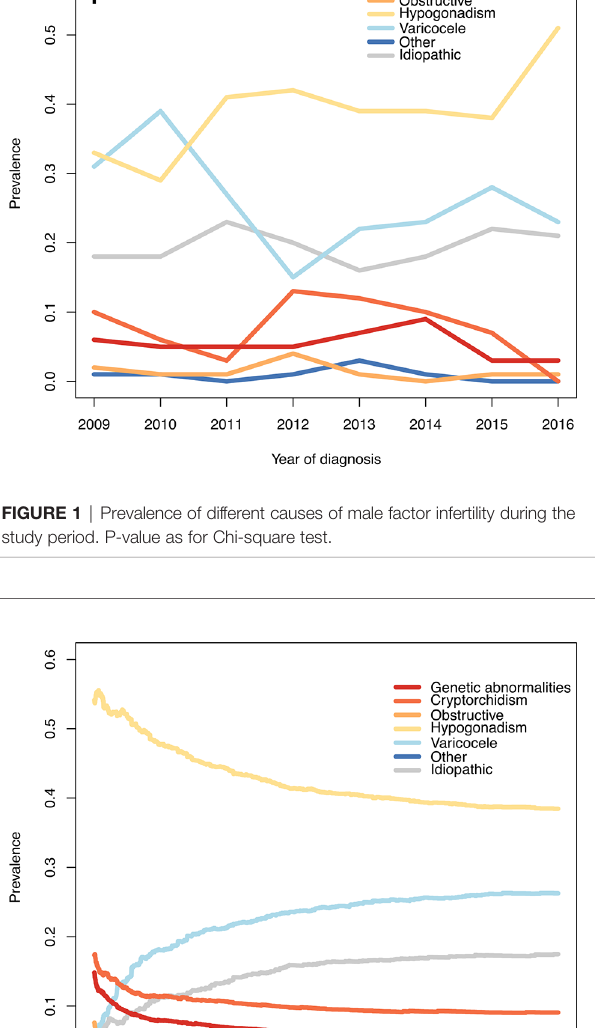
TABLE 2 | Multivariable OR and 95% CI for the diagnosis of idiopathic infertility in the study cohort [No. 1,147].